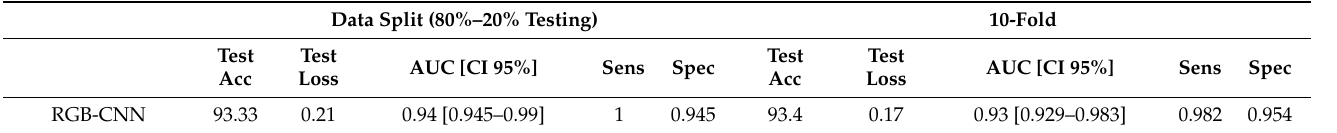
Table 5. Comparison of the evaluation metrics between the proposed data split method and 10-fold